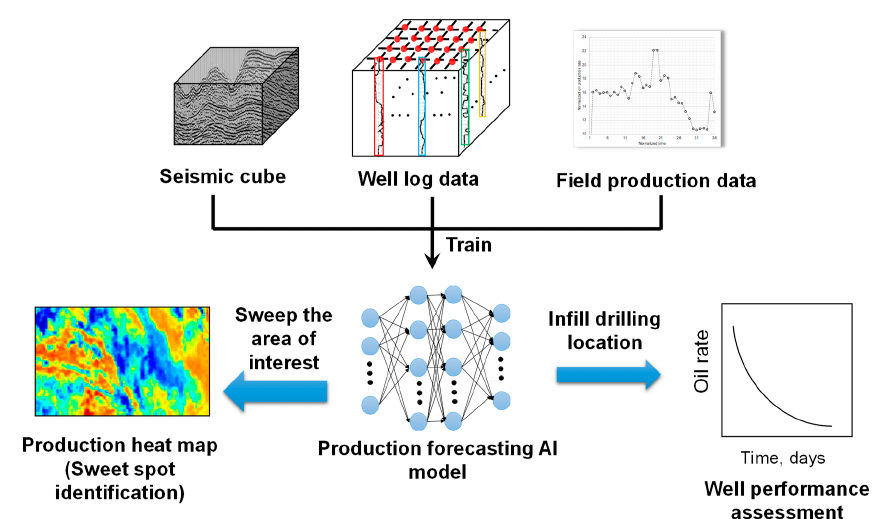
Figure 8. Workflow of intelligence system: Stage-II. Research works also compared the productivity heat map generated using the intelligence system against that from the conventional interpolation approaches. In Figure 9, one can observe that